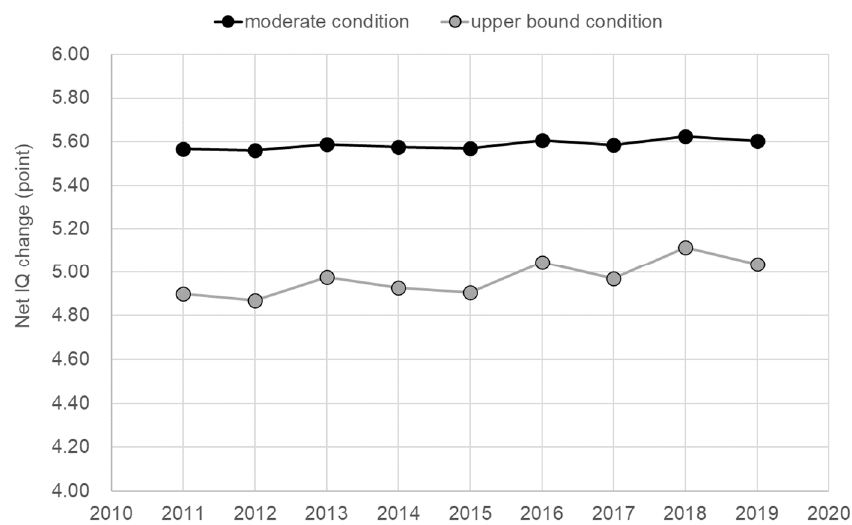
Figure 2. Temporal trend of net IQ change of infant estimated from maternal DHA and methylmercury intake during pregnancy.